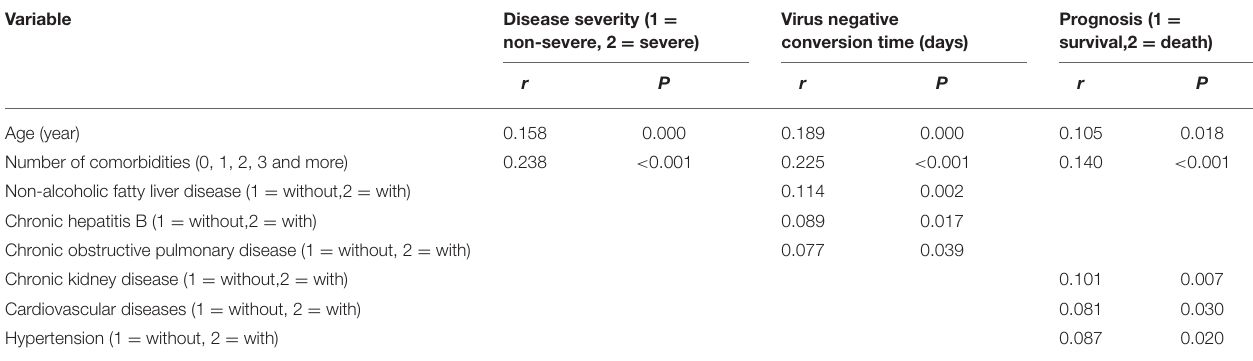
TABLE 5 | Spearman correlation analysis of disease severity, virus negative conversion time, prognosis, age and comorbidities ( n = 718). Variable